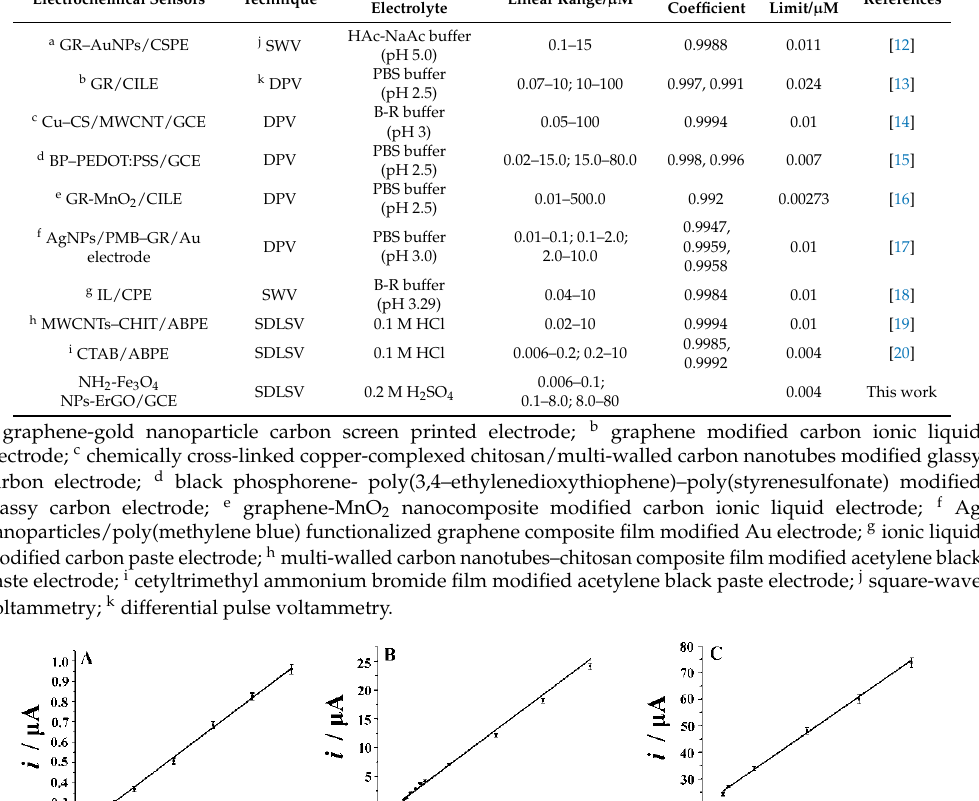
Table 4. Comparisons among various electrochemical methods for rutin detection. Electrochemical Sensors Technique Supporting Electrolyte